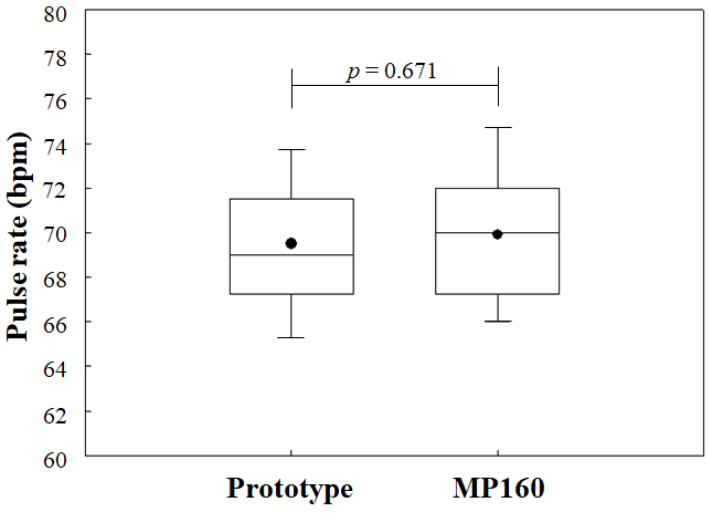
Figure 11. Boxplot of similarity analysis with Wilcoxon paired-samples test for heart rates of 20 subjects measured by the prototype device and the MP160.